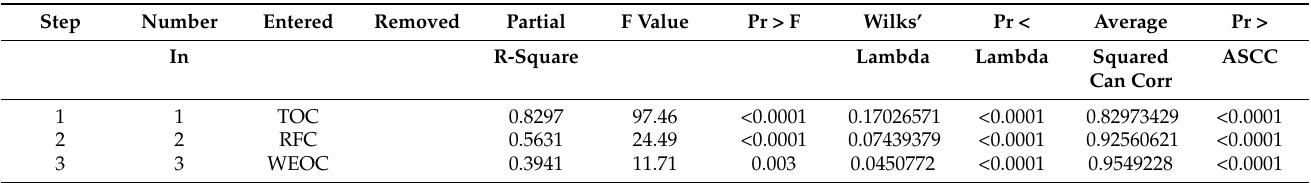
Table 6. Summary selection of STEPDISC procedure carried out on the whole dataset of chemical, physical and biological